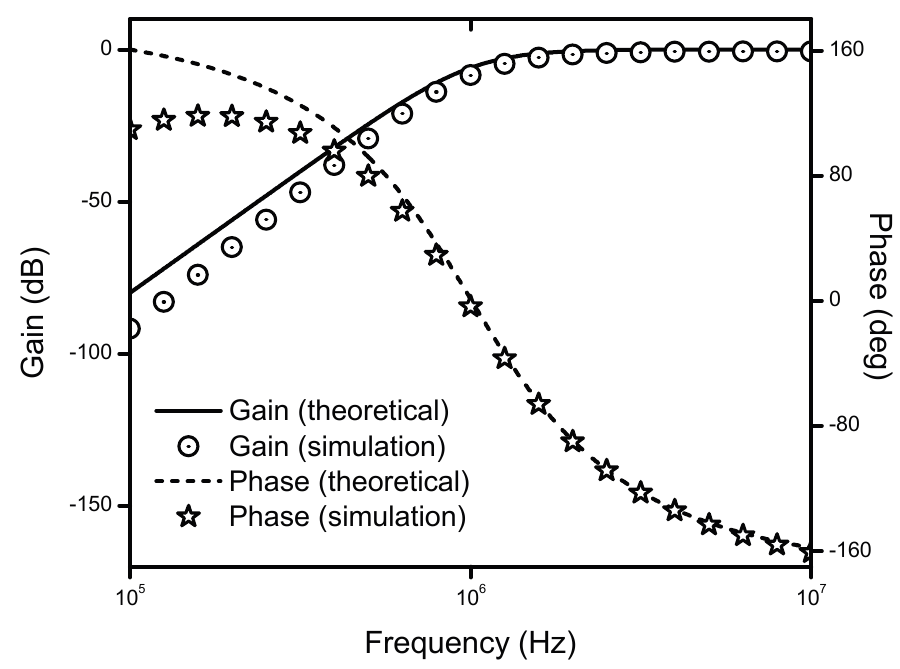
Figure 11. Frequency responses of the highpass function in Figure 5f.